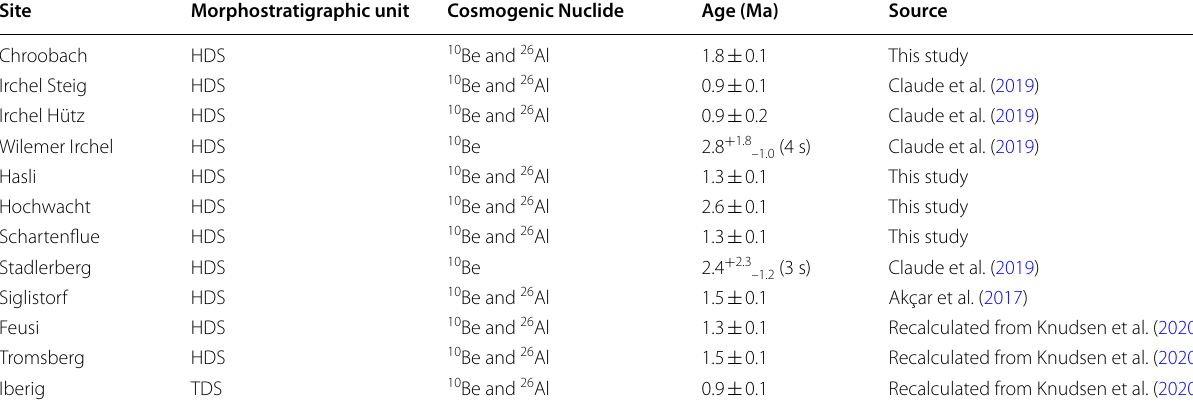
Confidence levels of the modelled depth-profile ages are indicated in parentheses. Reported isochron-burial ages are calculated based on a 26 Al/ 10 Be surface ratio of 7.6 0.8 after Akçar et al. (2017) within 1σ ±